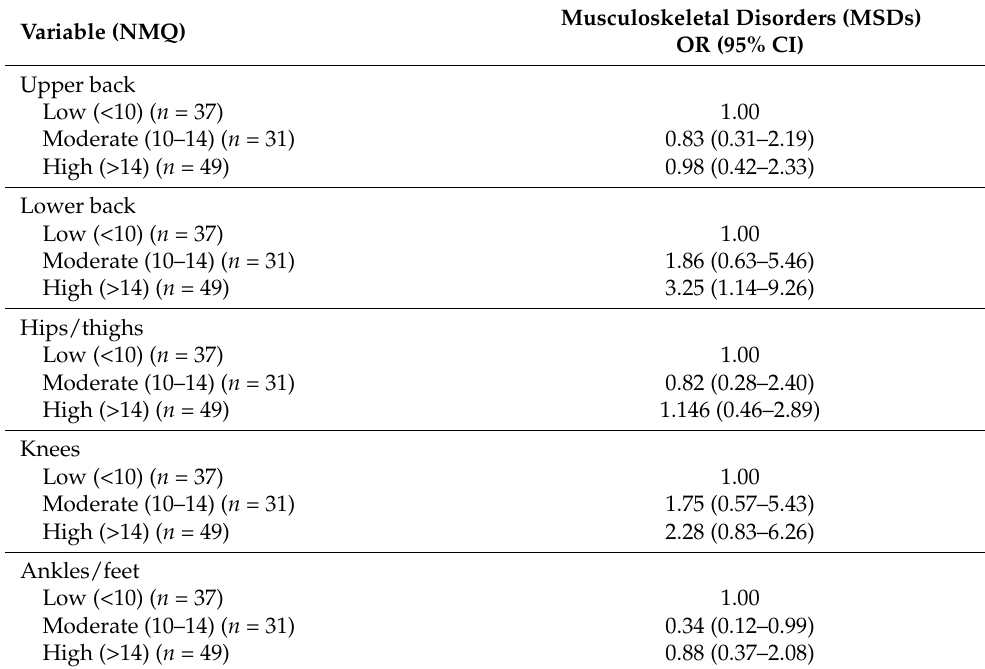
Table 4. Hazard ratio analysis between the NMQ and scale II of the checklist for